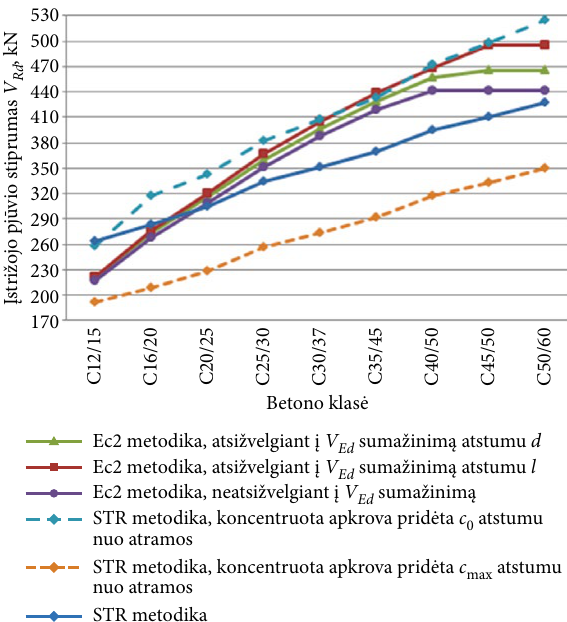
6 pav. Armuotų skersine armatūra lenkiamųjų elementų įstrižojo pjūvio stiprumo priklausomybė nuo skersinės armatūros (apkabų) žingsnio Fig. 6. The relationship between shear strength of bending elements with shear reinforcement and shear reinforcement (stirrups) spacing